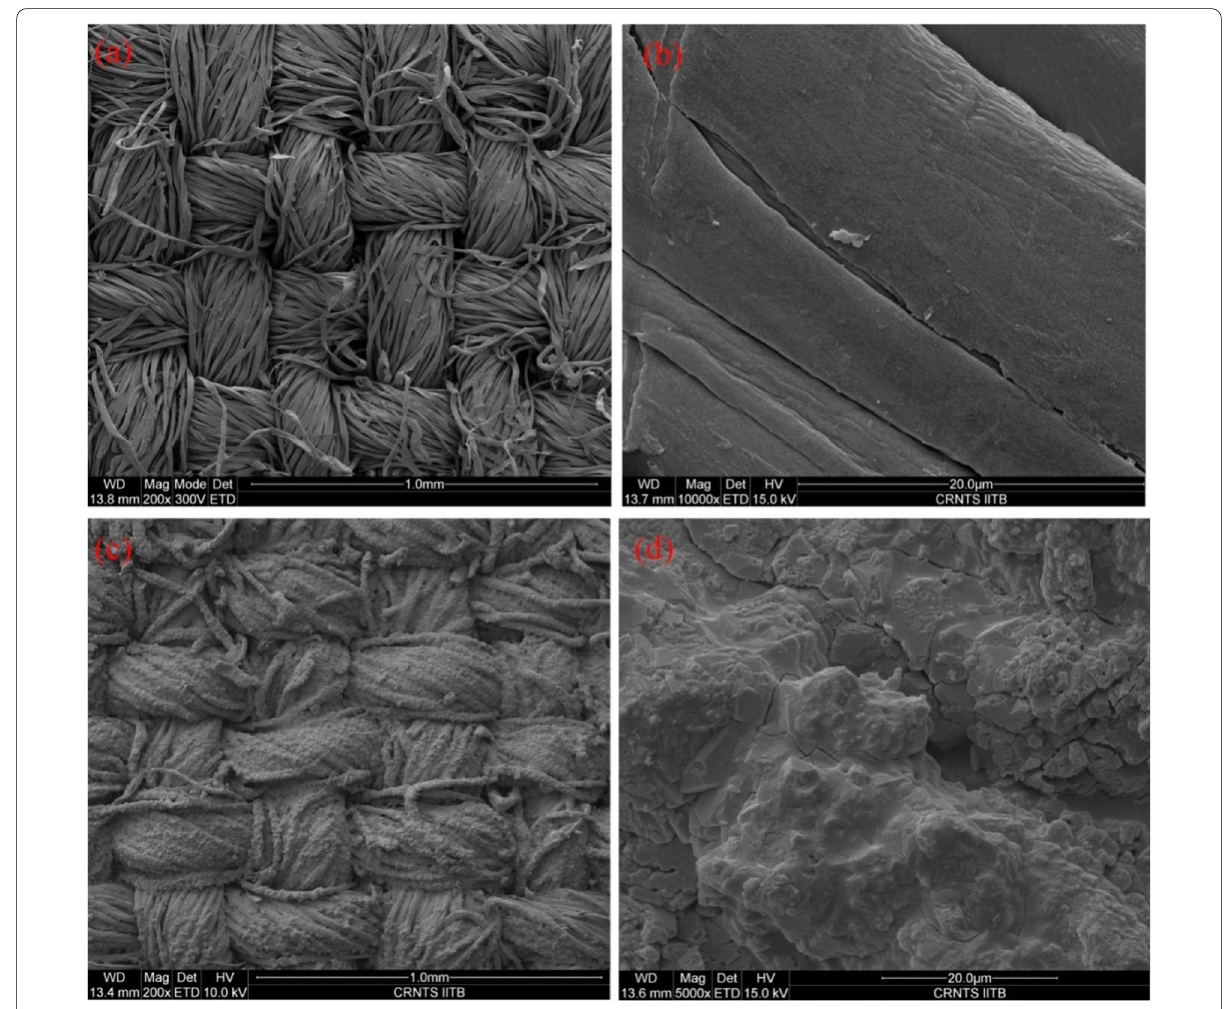
Fig. 4 ESEM images of ( a, b ) untreated and ( c , d ) treated cotton